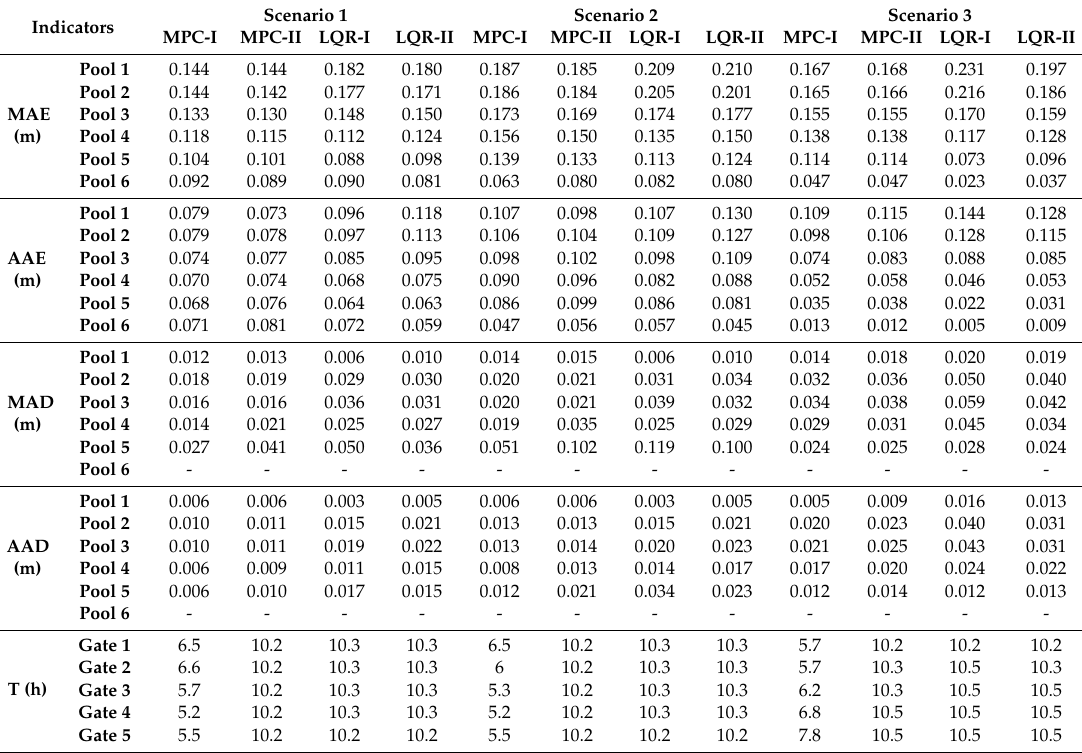
Table 3. Summary of simulation